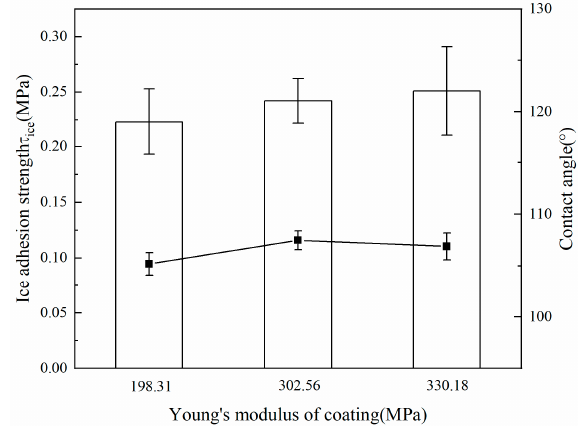
Fig ure 12 . Adhesion strength and contact angle of different Young’s modulus coatings